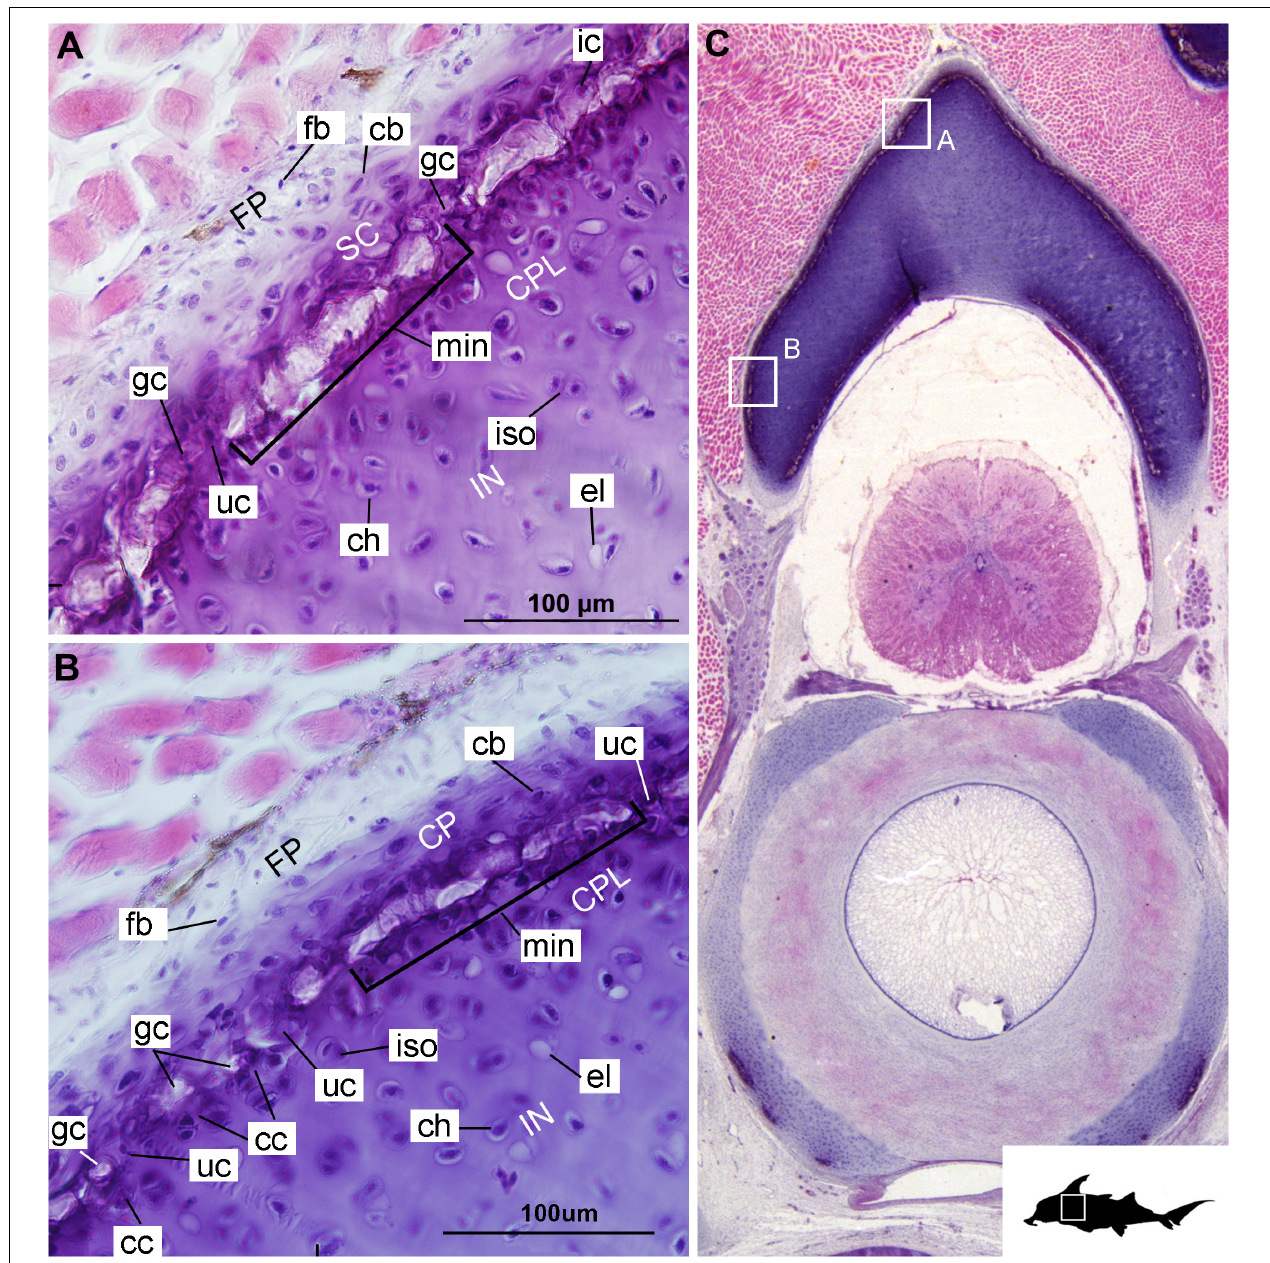
FIGURE 2 | Histological section through the anterior synarcual (anterior fused vertebrae) of a stage 36 embryo of Callorhinchus milii (Holocephali; Callorhinchidae). (A,B) Closeups showing perichondrium, cartilage, and mineralization in the neural arch; (C) overview of section with locations of closeup views indicated by white squares. Abbreviations: As in Figure 1 , also cc, clustered chondrocytes CPL, chondrocyte proliferative layer; el, empty chondrocyte lacunae; gc, calcification globule; ic, chondrocyte that is being engulfed or has been incorporated; uc, uncalcified cartilage; IN, internal cartilage; SC, supratesseral/mineral cartilage. Black silhouette of C. millii indicates approximate region shown in the